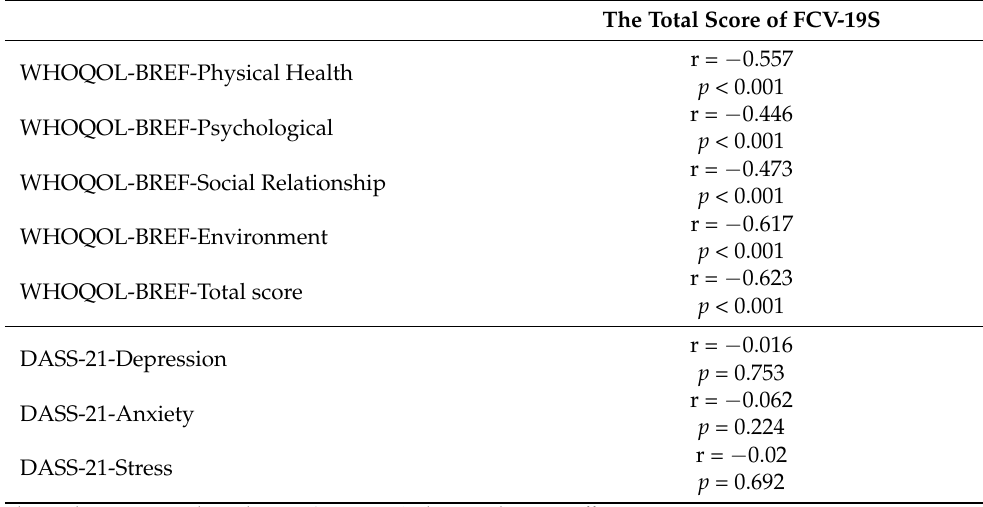
Table 4. The correlation coefficient (r) among the FCV-19S (total score), WHOQOL, and DASS-21. The Total Score of